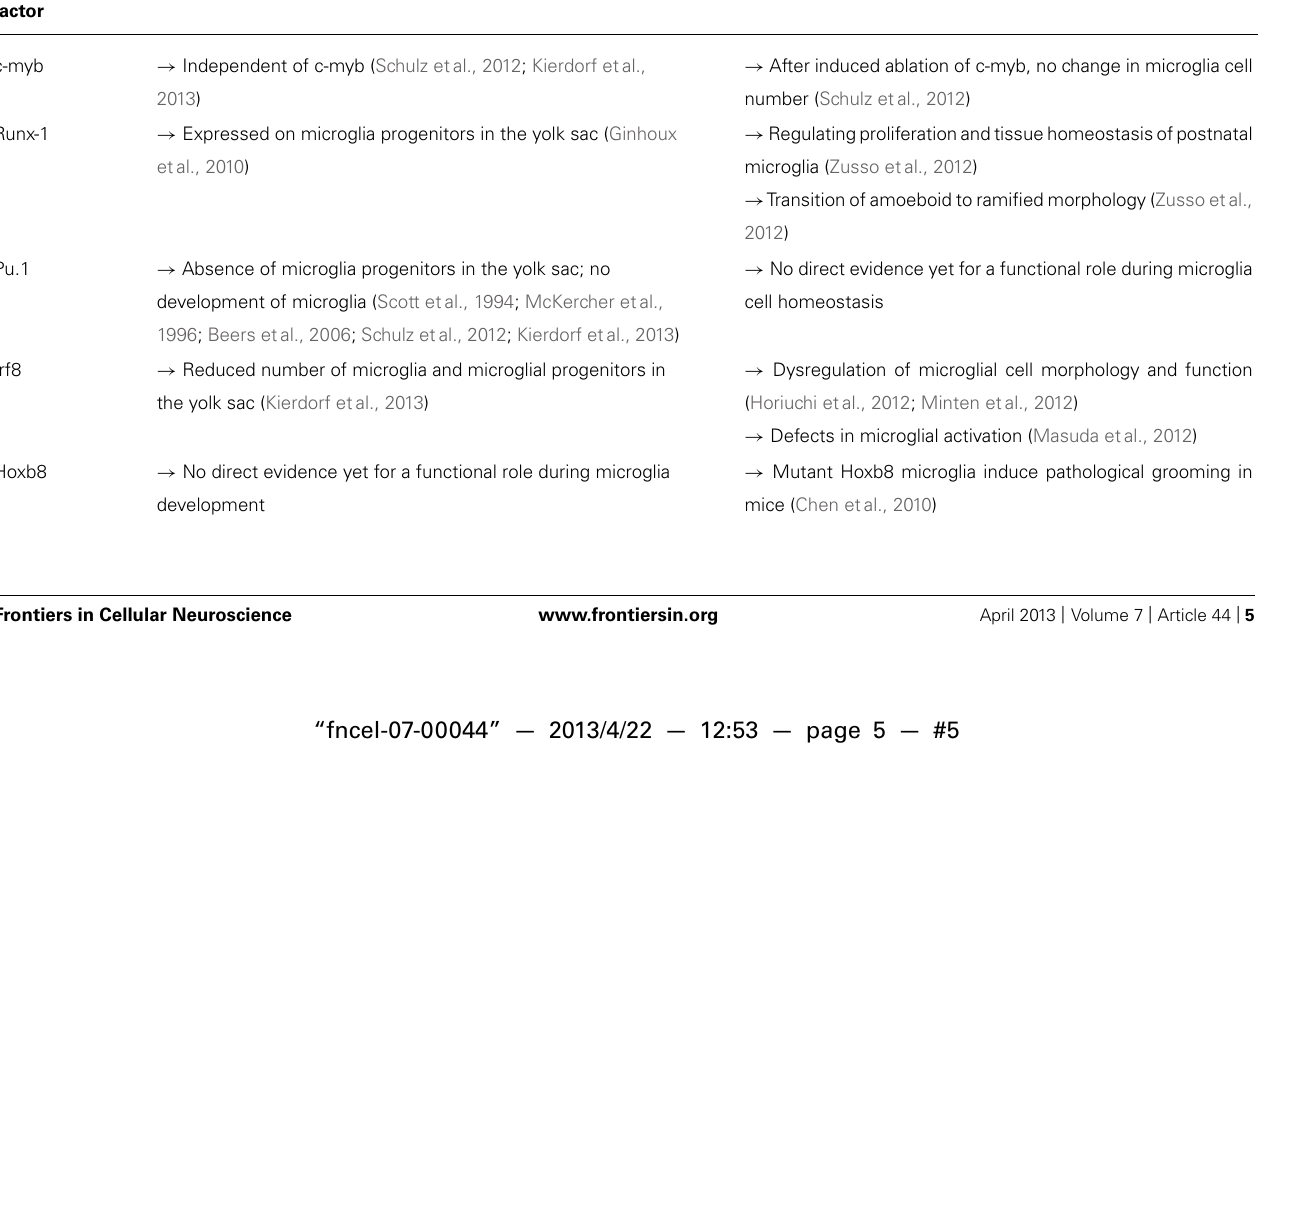
Table 1 |Transcription factors regulating microglia development and